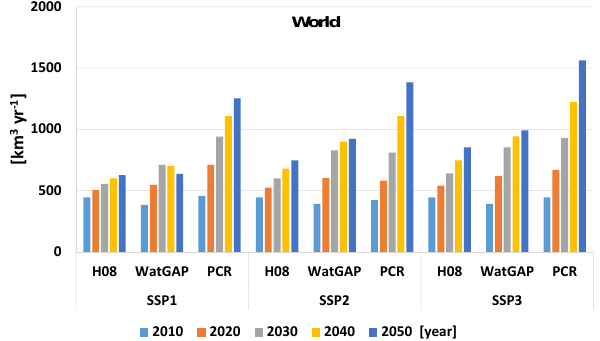
Figure 4. Global domestic water withdrawal projections calculated by the global water models H08, WaterGAP (WatGAP), and PCR- GLOBWB (PCR) for the years 2010, 2020, 2030, 2040, and 2050, respectively, under three SSP scenarios (SSP1, SSP2, and